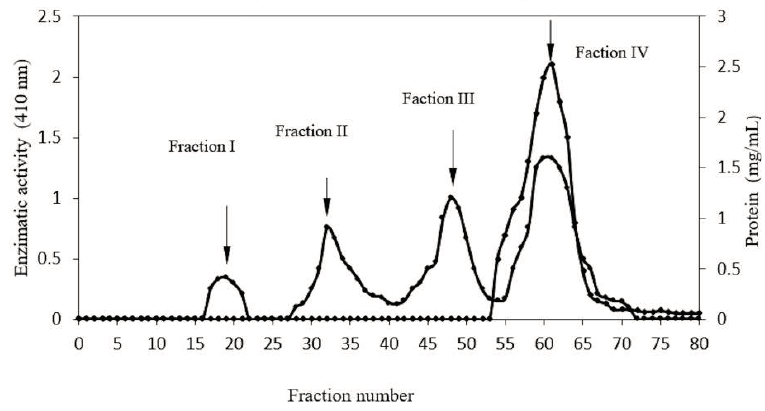
Figure 2. Profile of purification of β -glucosidase in S. edule . Gel filtration Sephacryl S-200HR, equilibrated using phosphate buffer (0.2 M, pH 6.7). 5 mg of protein was applied and eluted at flow rate of 16 mL/h, collecting 1.5 mL fractions. Protein concentration ( ●─● ) and enzymatic activity ( ♦─♦ ) was taken for each